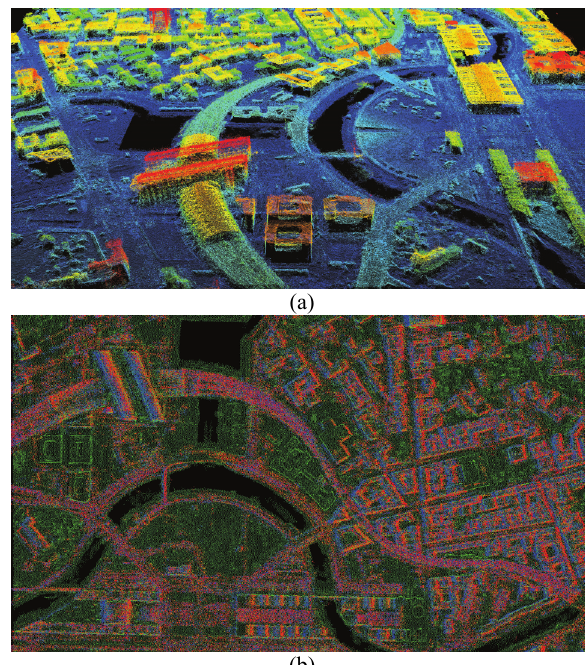
Figure 7. (a) the fused point cloud combining the optical images-derived one and two TomoSAR point clouds from ascending and descending viewing angle with color representing the height, and (b) the top view of co-registered point cloud where red, blue, green representing the points from descending TomoSAR, optical, and ascending TomoSAR, respectively.